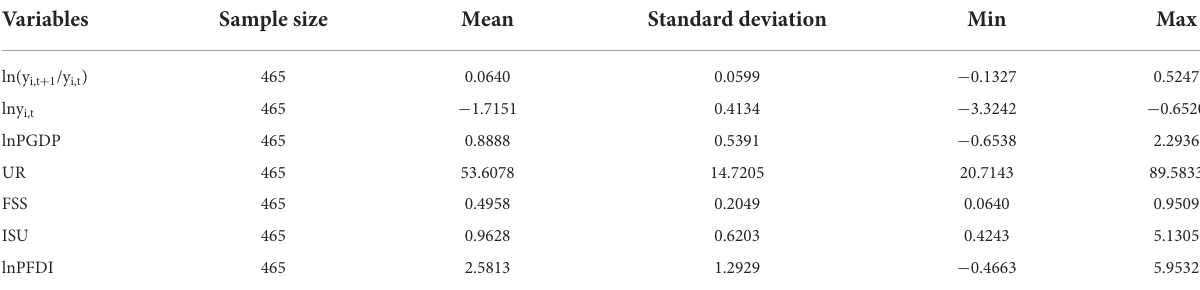
TABLE 2 Summary statistics of